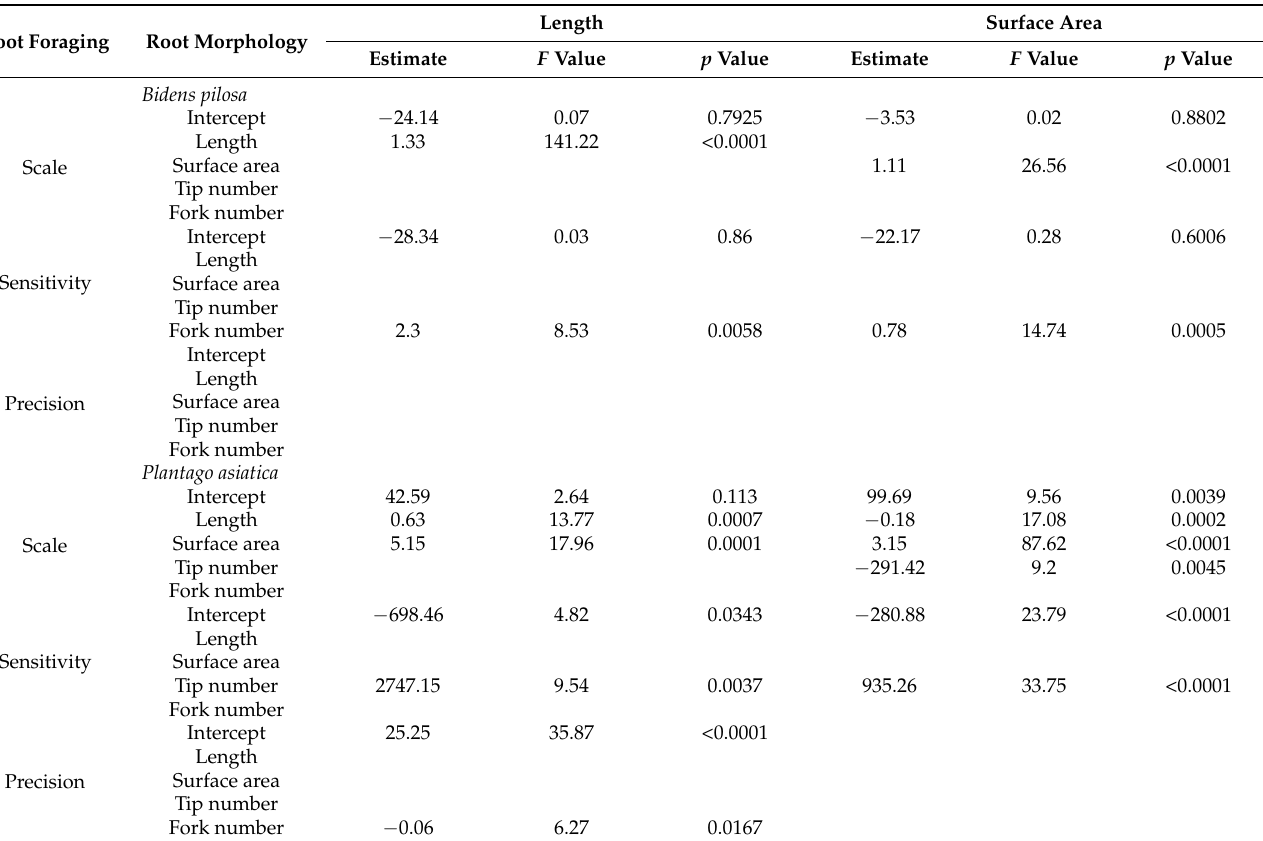
Table 3. Multivariate linear regression of root foraging parameters of scale, sensitivity, and precision of length and surface area against dependent variables of fine root morphologies of length, surface area, tip number, and fork number.